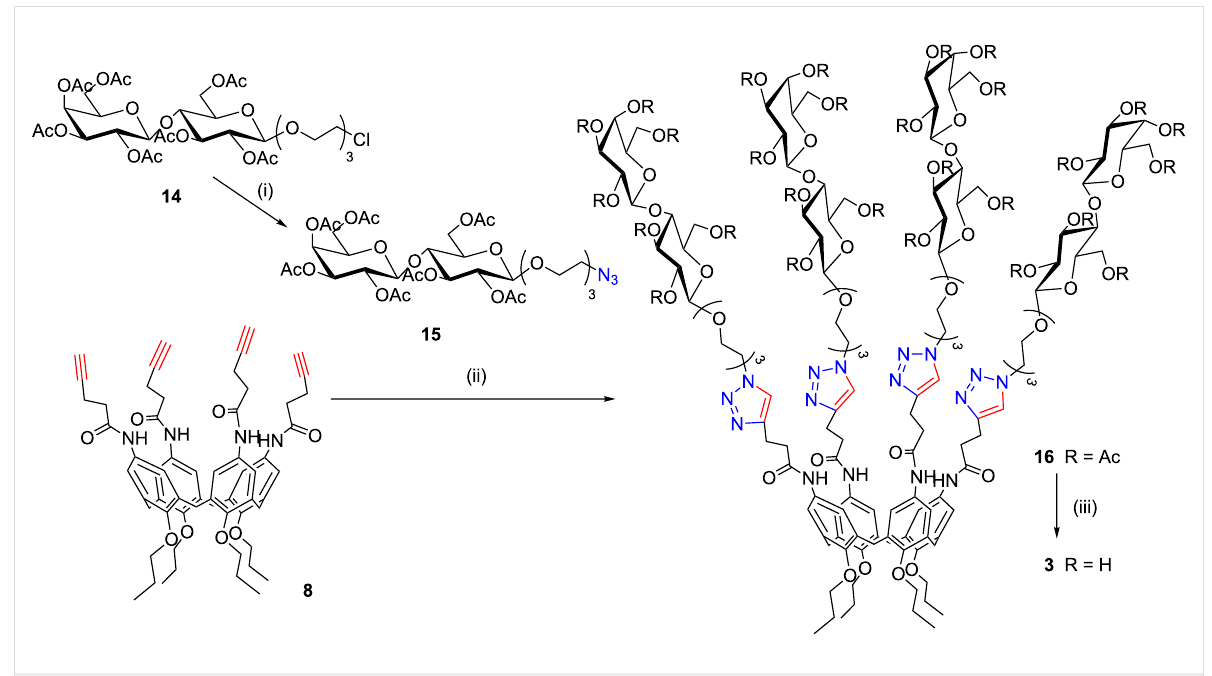
Scheme 3: Synthesis of the cone lactosylcalix[4]arenes 3 . Reaction conditions: (i) NaN 3 , n -Bu 4 NI, DMF, 90 °C, 24 h, 60%; (ii) CuSO 4 ·5H 2 O, Na-ascorbate,